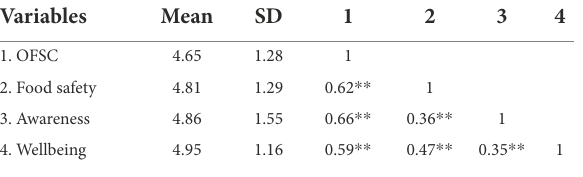
TABLE 3 Means, standard deviations, and correlations for relevant variables.